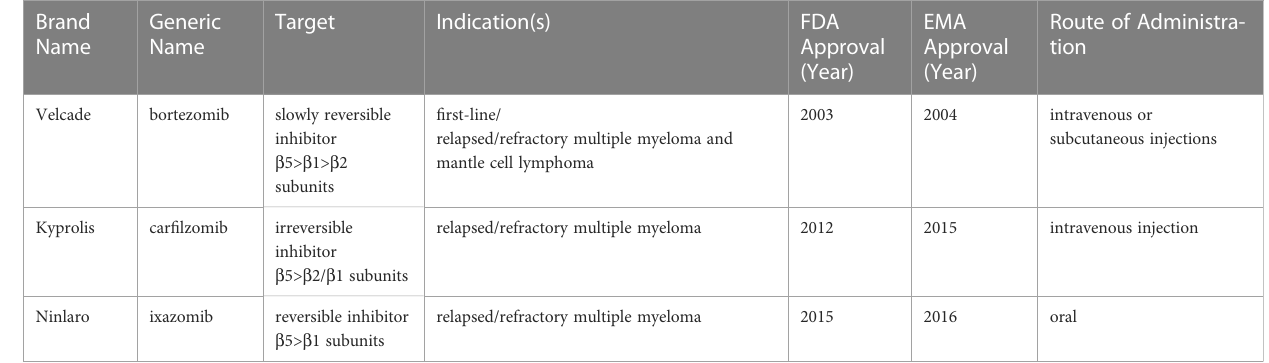
TABLE 1 Current FDA/EMA approved